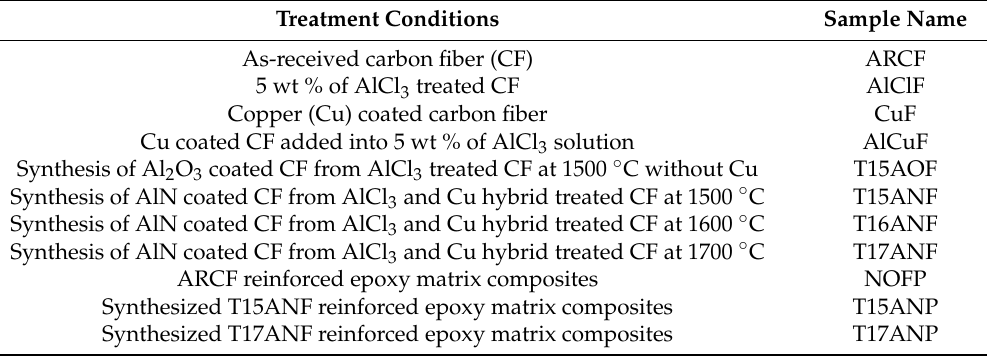
Table 2. Sample Names Denoted According to Treatment